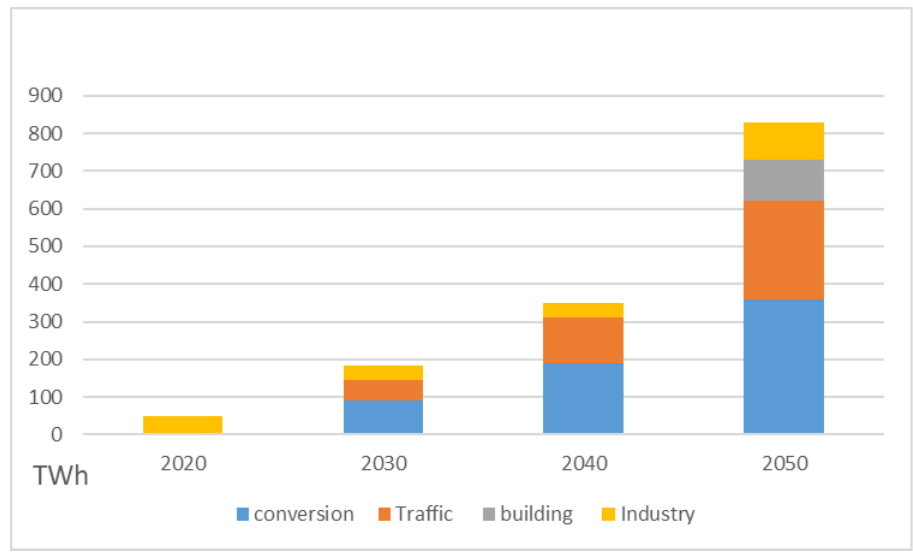
Figure 14. Development of the annual hydrogen demand by sector in the baseline scenario [86].